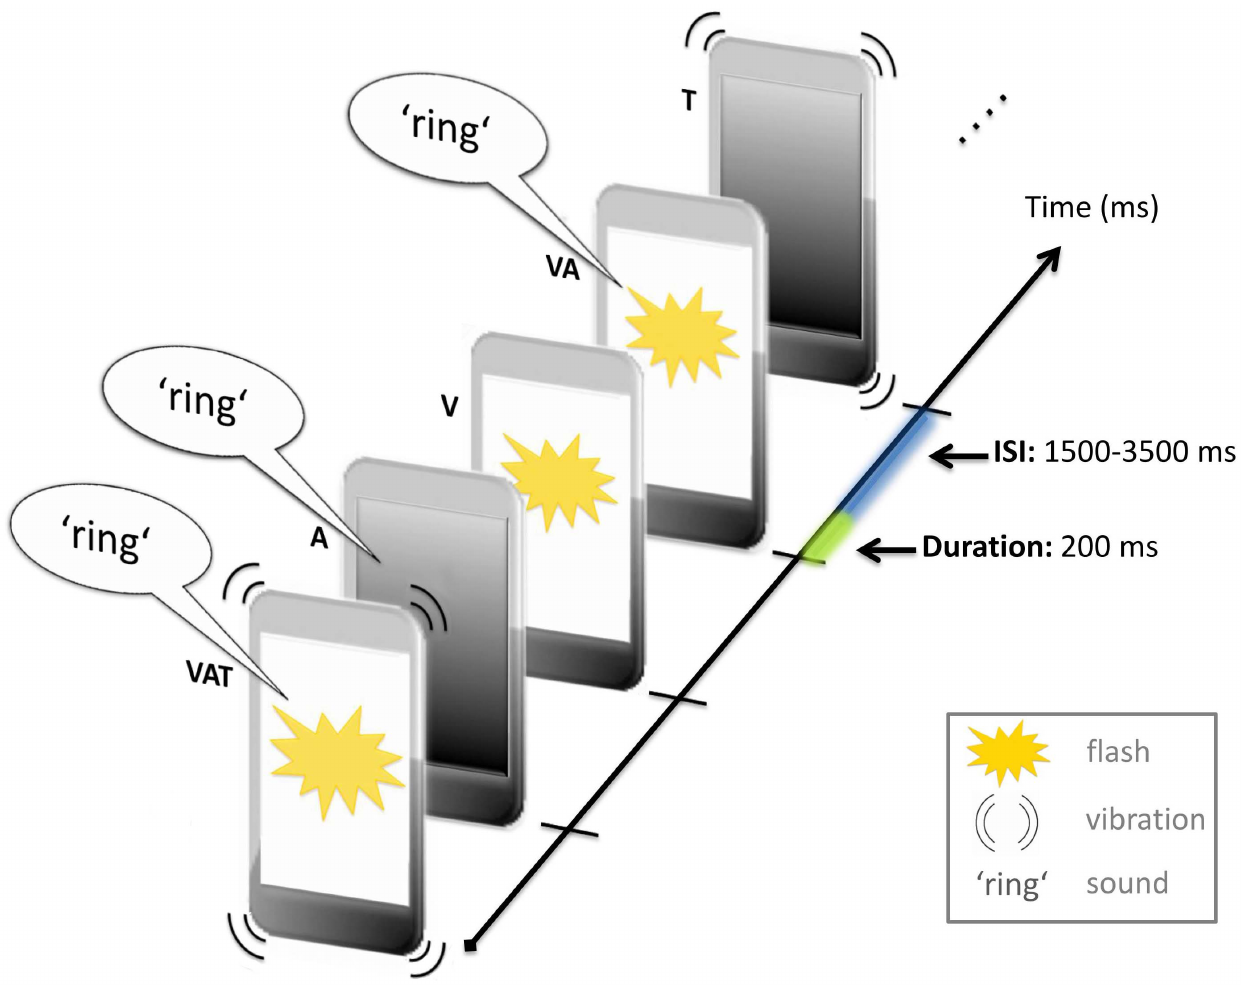
Figure 2. Illustration of the stimulation sequence. A continuous stream of unisensory visual (V), auditory (A), and tactile (T), bisensory VA, VT, VA, and trisensory VAT stimuli was presented in random order.